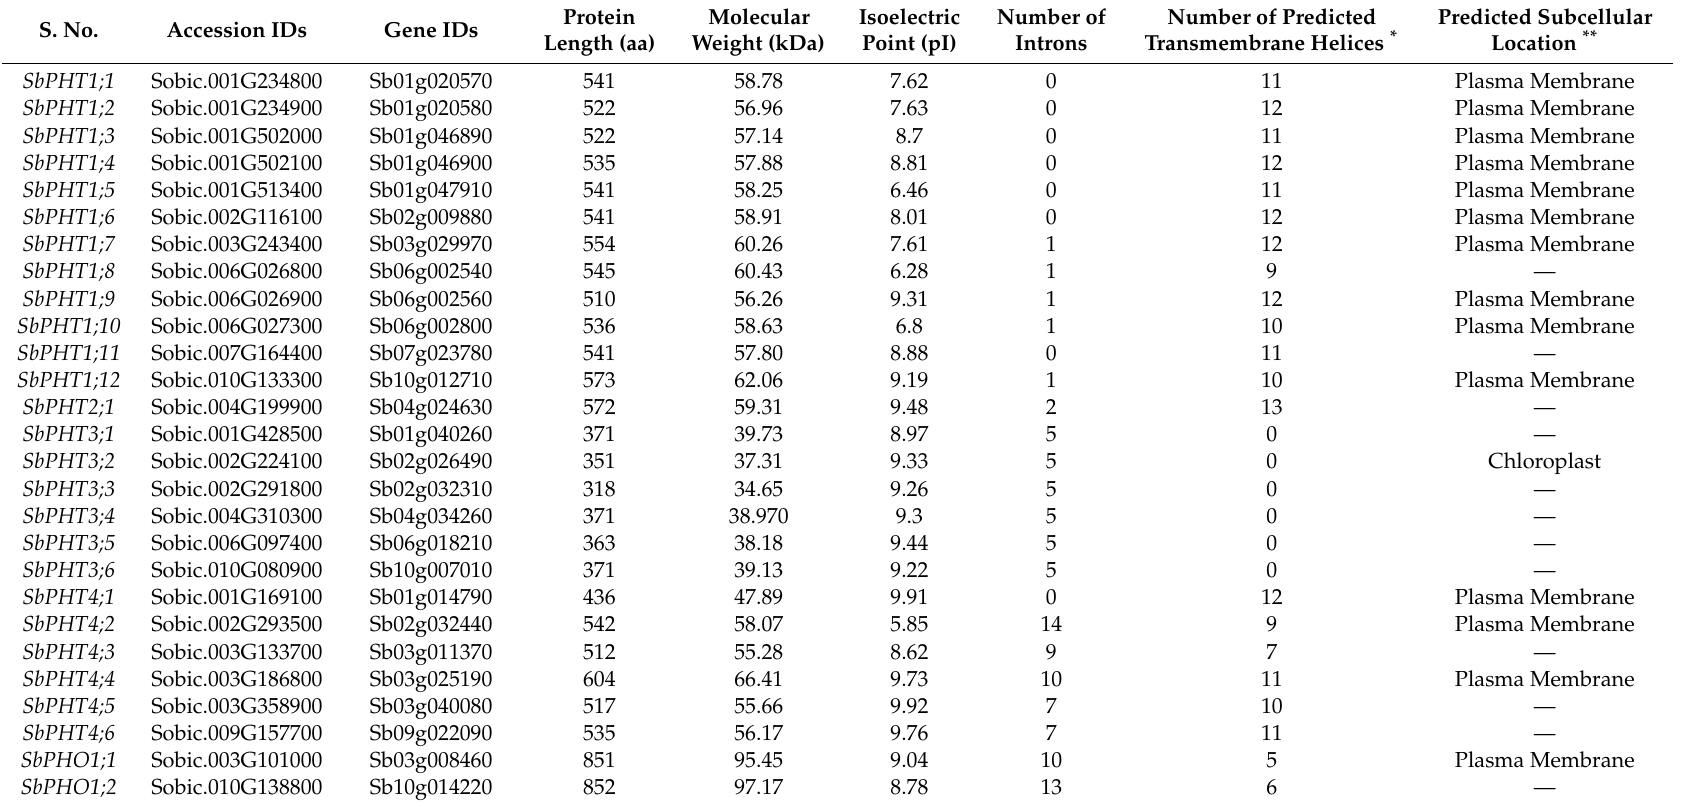
Table 1. Key features of SbPHT